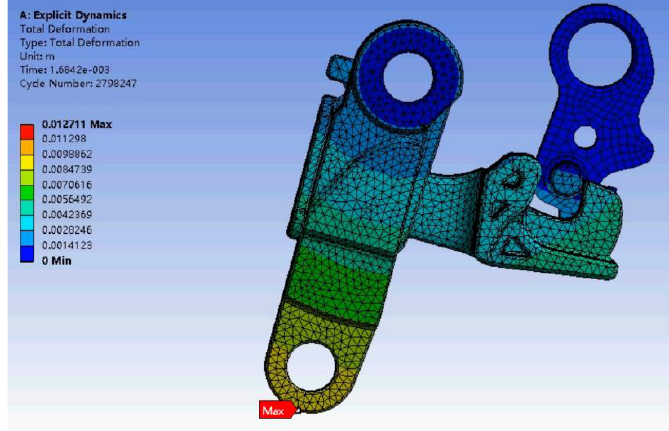
Figure 15. The end state of the door latch simulation movement.